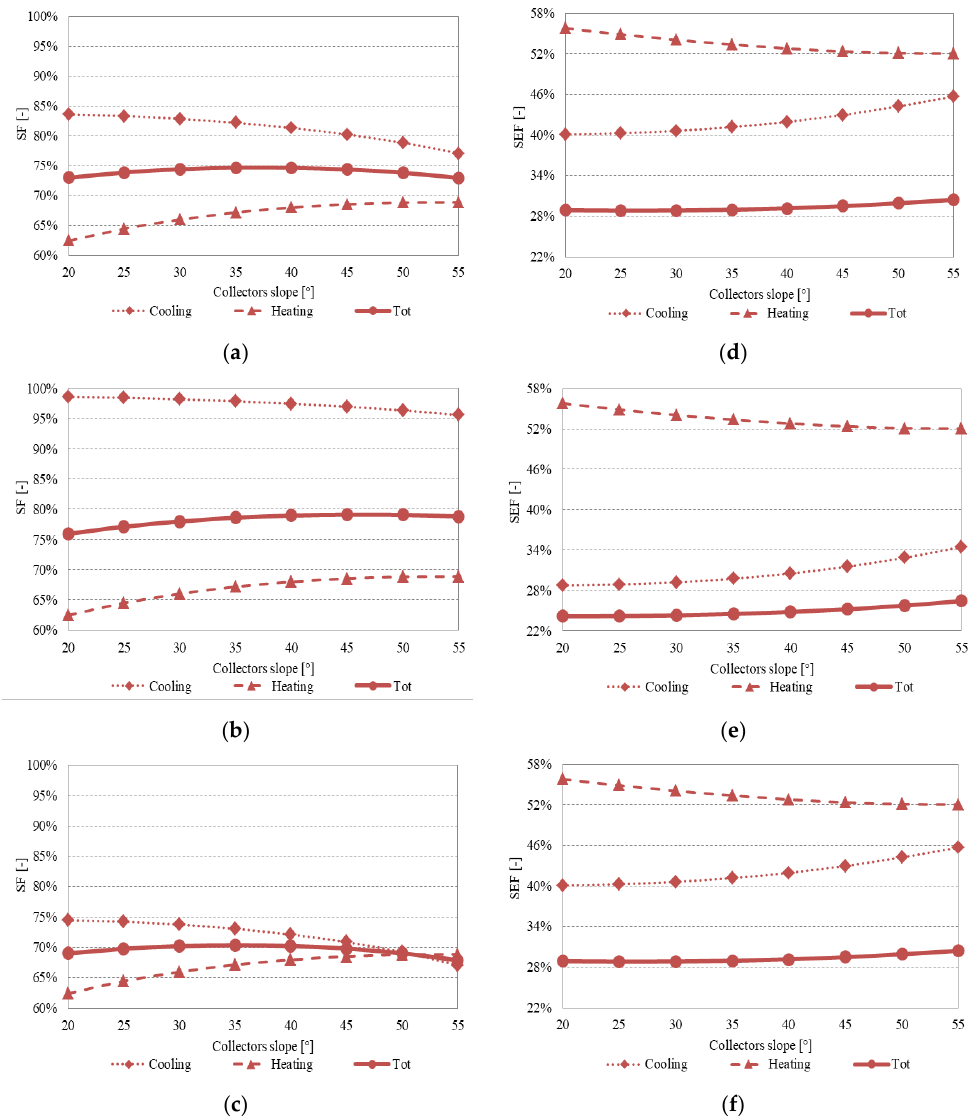
Figure 5. Solar fraction (left side) and solar energy factor (right side) as a function of the tilt angle in cooling operation, heating operation and total, for the plant with 27 m 2 of solar collectors and the innovative AHU equipped with: ( a , d ) silica-gel DW, ( b , e ) MILGO DW and ( c , f ) zeolite-rich tuff DW.